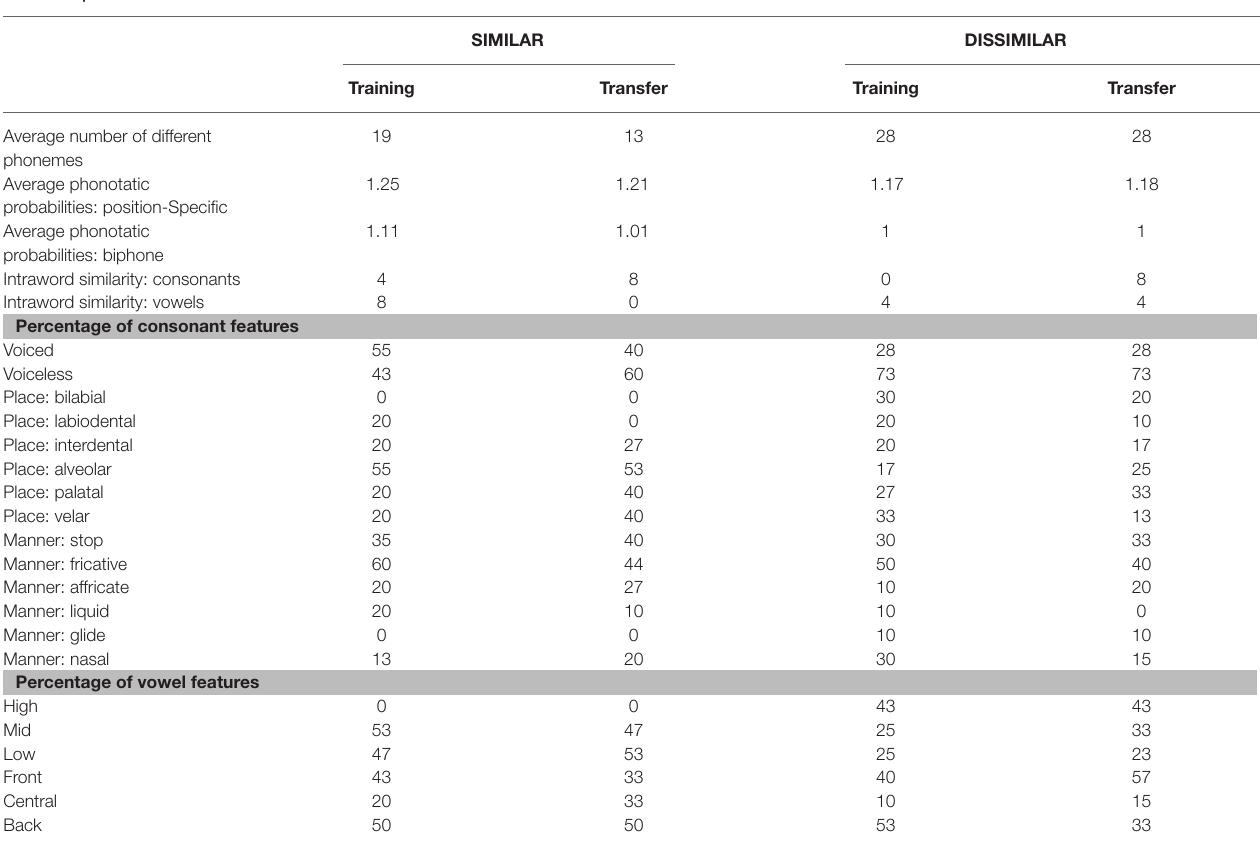
TABLE 2 | Stimuli set